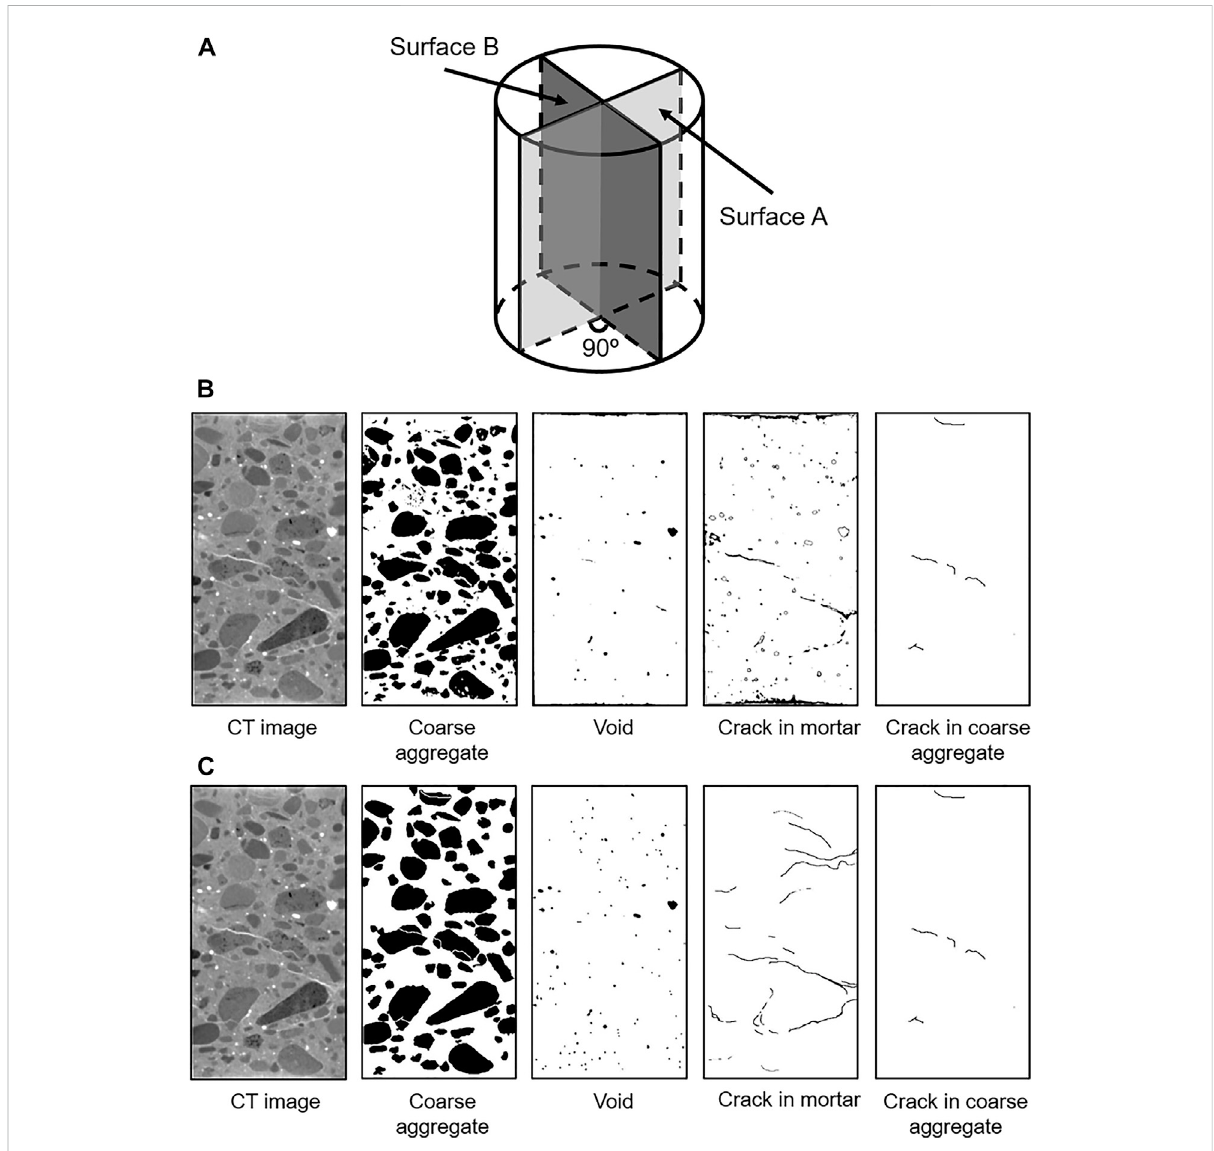
FIGURE 4 Extracted particles. (A) Observation surfaces. (B) Before manual operations. (C) After manual operations.